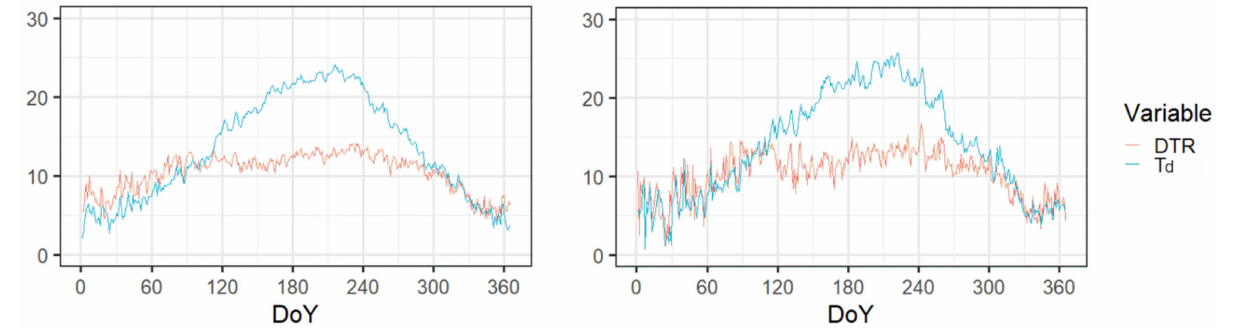
Figure 9. Annual trend of DTR ( ◦ C) and T d ( ◦ C) at RS climate station for 1990–2020 ( left ) and 2013–2020 ( right ).